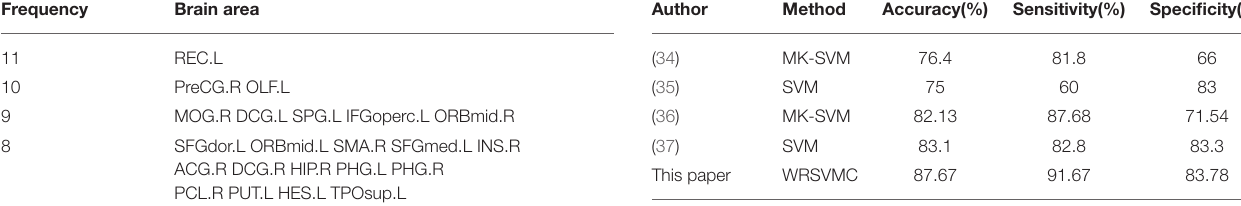
TABLE 3 | The brain areas with higher frequency. Frequency